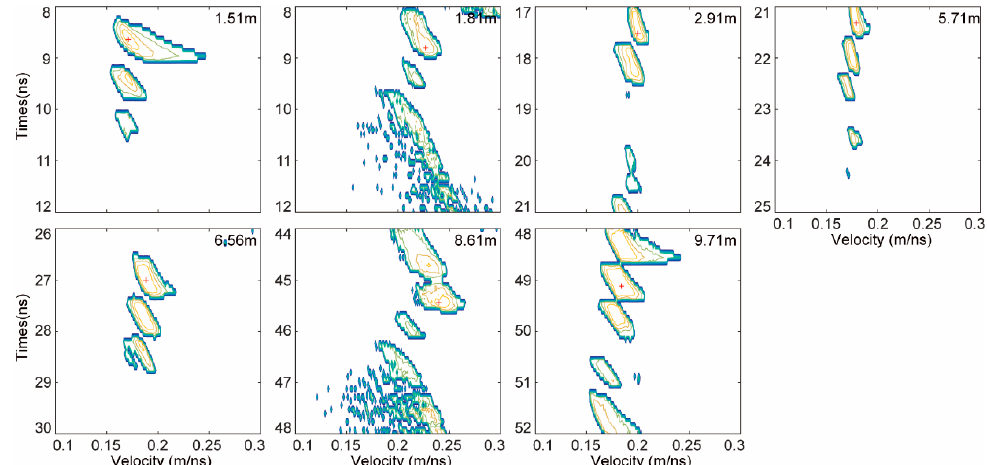
Figure 4. Semblance analysis contours of selected diffraction hyperbolas for the simulation model, where the normalized stacked amplitude threshold of 0.6 was used. The red-cross indicates the maximum value 1 of the semblance analysis. Table 1. The estimated results of velocity and depth for the simulation model.